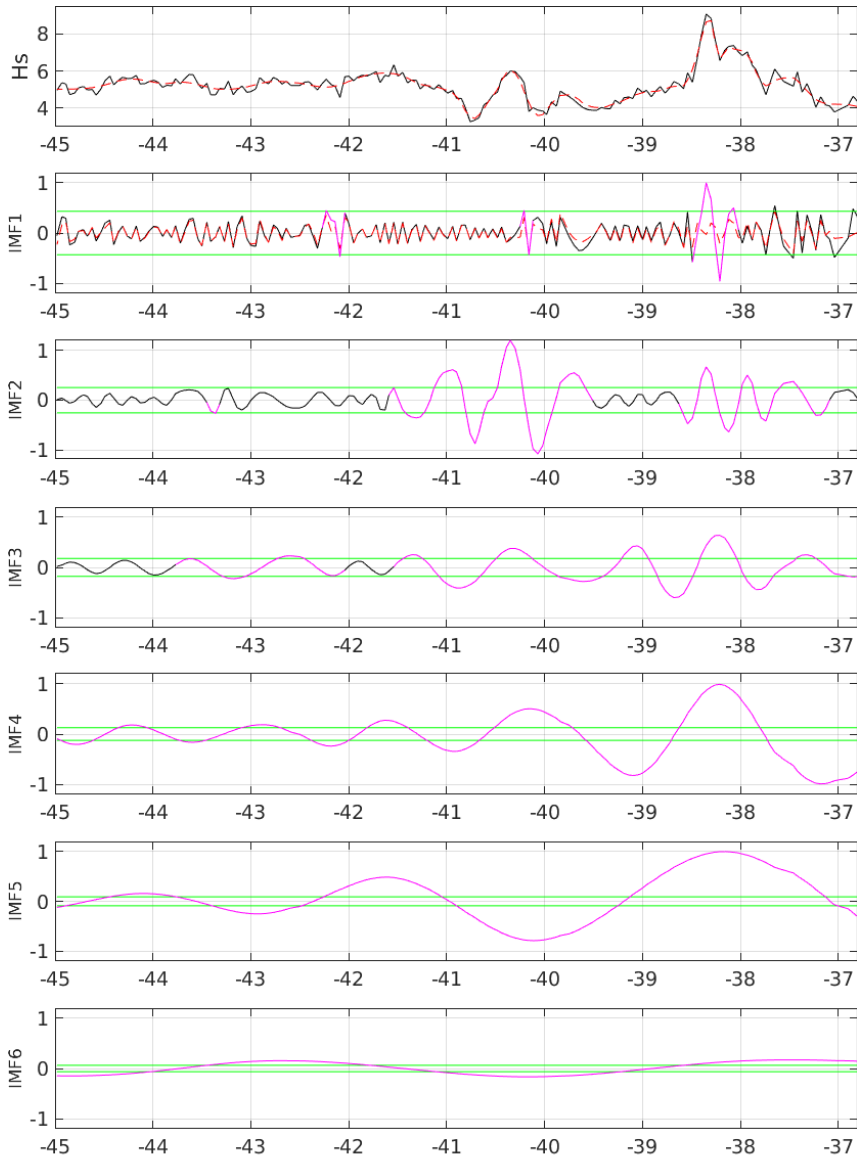
Figure 8. EMD expansion in L IMFs (IMF2 to 6 from top to bottom) for a data segment of JASON-2 raw (solid black line) and filtered (dashed red line) SWH measurements on 29 February 2016 (top panel). For the IMFs, the black lines show the IMF amplitudes and the superimposed magenta lines the signal portions identified as above the predicted noise level (solid green lines). For this particular case, portions of signal that are dominated by noise are found solely in the three first IMFs. For IMF1, the dashed red line shows the high-frequency noise series that has been computed from IMF1 wavelet processing. As obtained, six IMFs describe the total